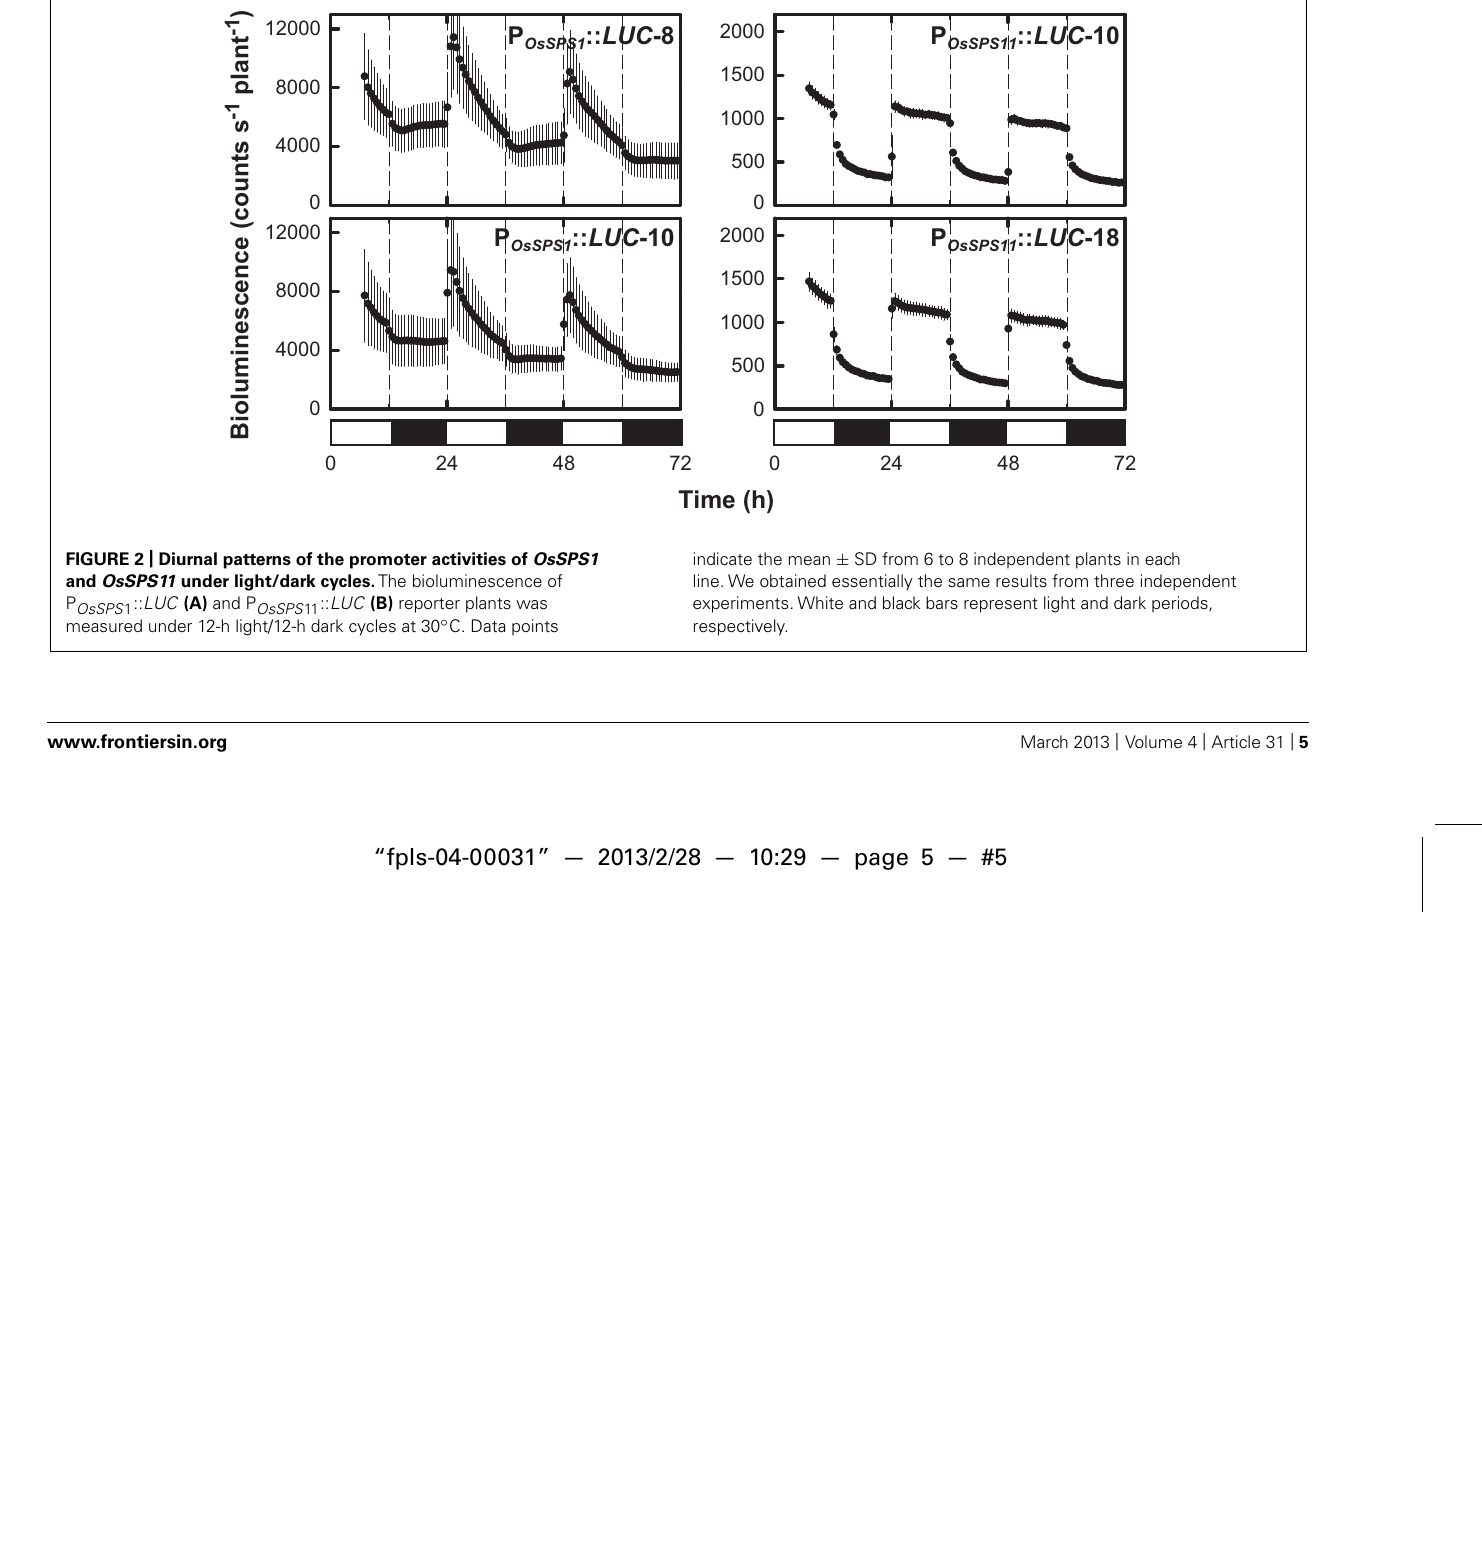
indicate the mean ± SD from 6 to 8 independent plants in each line.We obtained essentially the same results from three independent experiments.White and black bars represent light and dark periods,